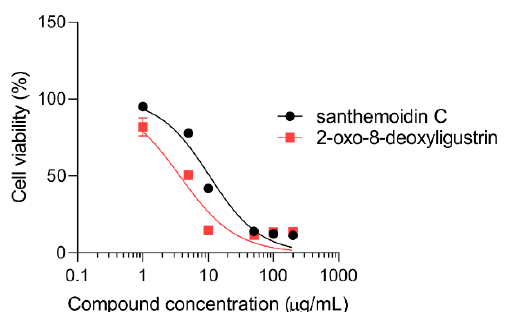
Figure 3. Cytotoxicity evaluation of the STLs on mammalian cells. Vero cell viability was determined by the MTT method in the presence of either santhemoidin C or 2-oxo-8-deoxyligustrin. Cells were incubated for 48 h with increasing concentrations of the compounds. Results are expressed as a percentage of viability. Bars represent the means ± SEM.